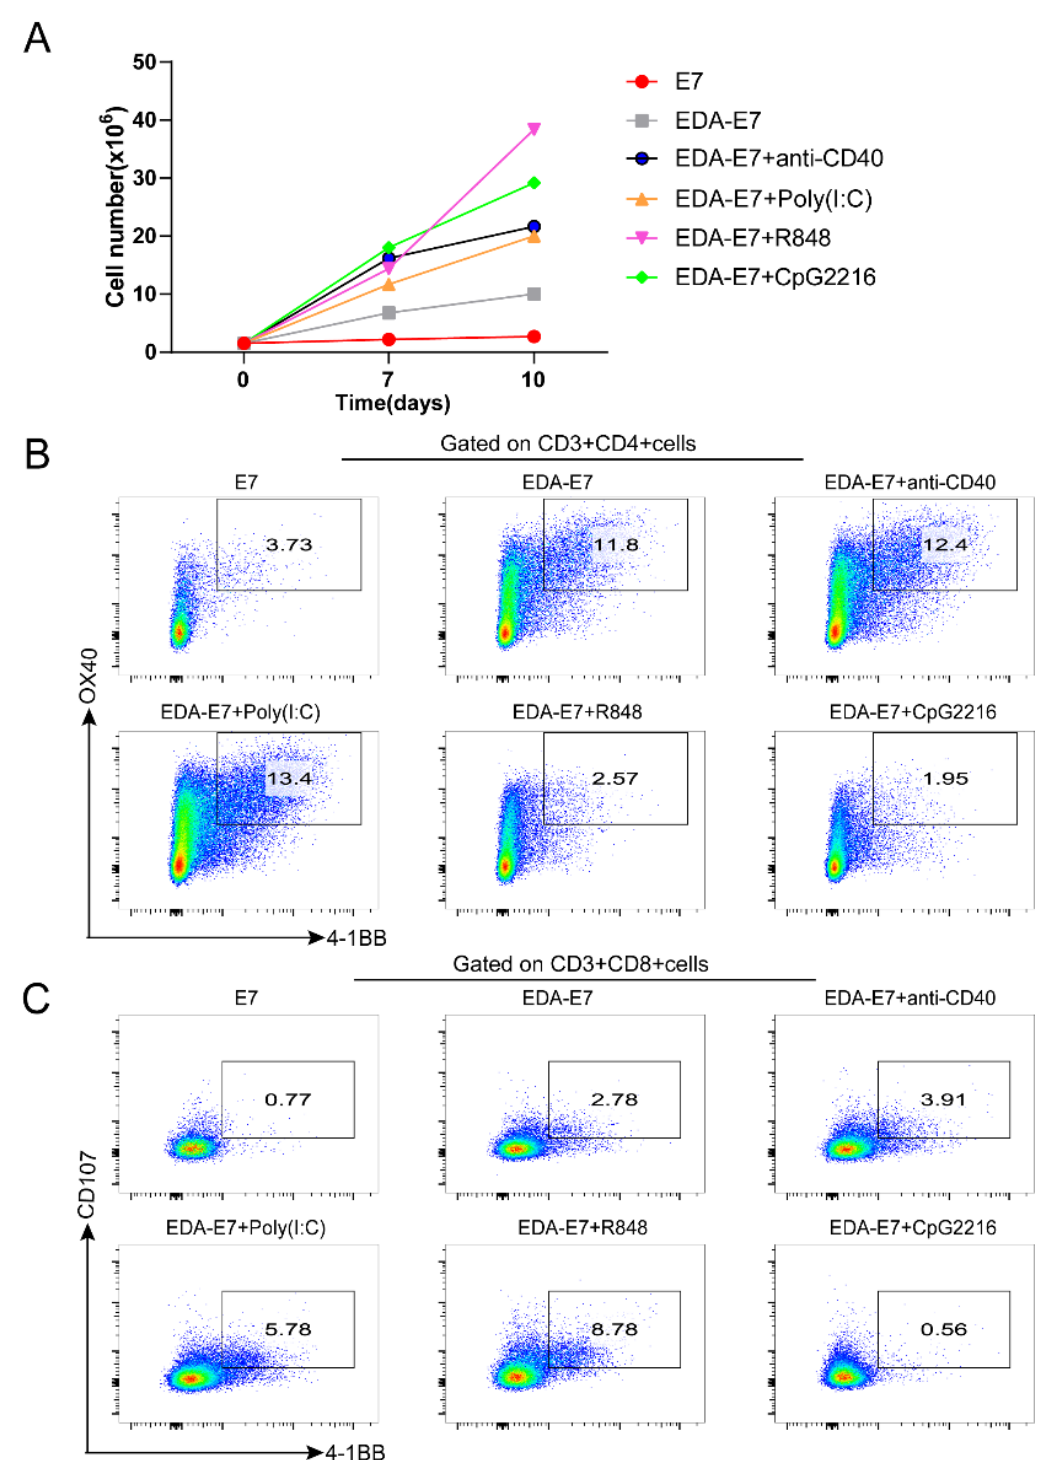
Figure 5. Combined use of EDA-E7 with TLR agonist upregulated the activation of CD4 + T and CD8+ T cells by DCs compared to EDA-E7 alone or E7. T cells growth curve after coculture with DCs, n = 3 per group ( A ); Flow cytometry for activation markers of CD4 + T cells ( B ); Flow cytometry for activation markers of CD8+ T cells ( C ).